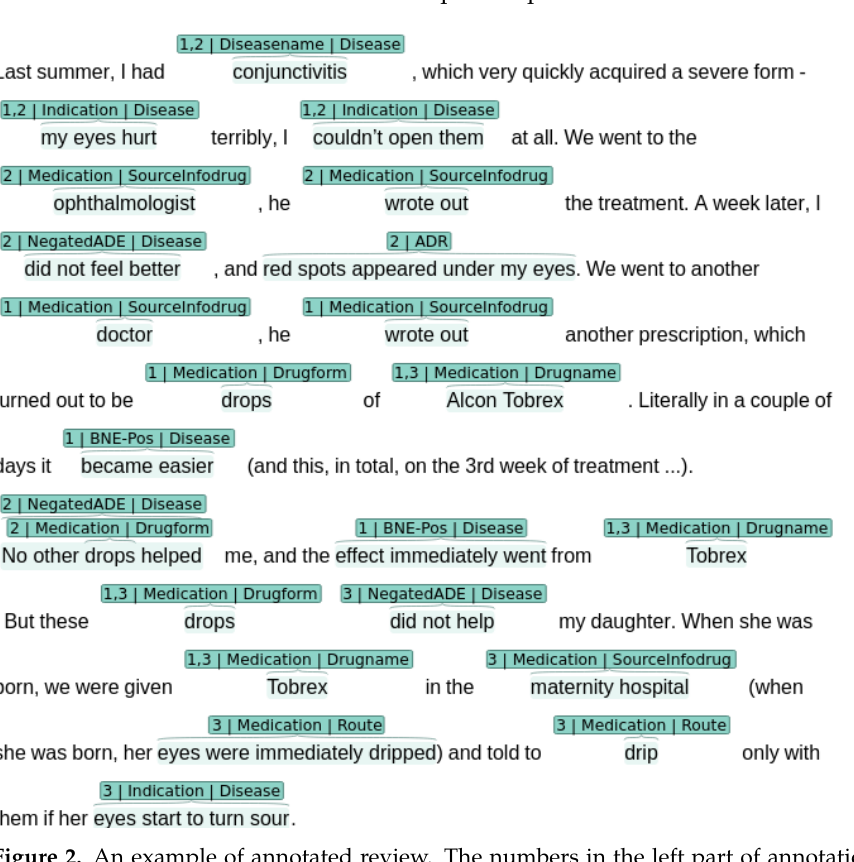
Figure 2. An example of annotated review. The numbers in the left part of annotations indicate the contexts to which the entities belong. In this particular example, there will be 9 positive and 6 negative relations Drugname–SourceInfodrug, 2 positive and 1 negative Diseasename–Indications, 3 positive Drugname–Diseasename and 3 negative